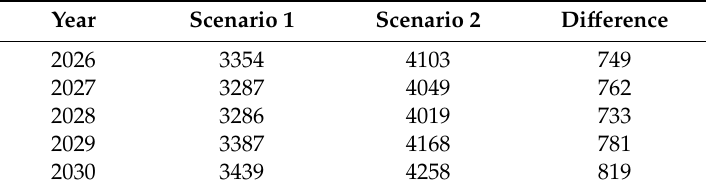
Figure 9. Yearly average PUN (Prezzo Unico Nazionale—national unique wholesale price) trend with Hypothesis 1 (HYP.1) (without consideration of bid-ups). Table 4. Equivalent hours of the combined cycle gas turbine (CCGT) plants from the simulations with HYP.1.